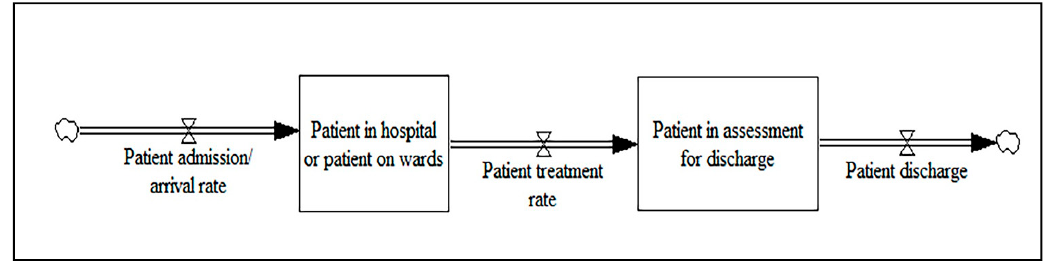
Figure 4. The core part of the stock-flow diagram for the patient flow model.